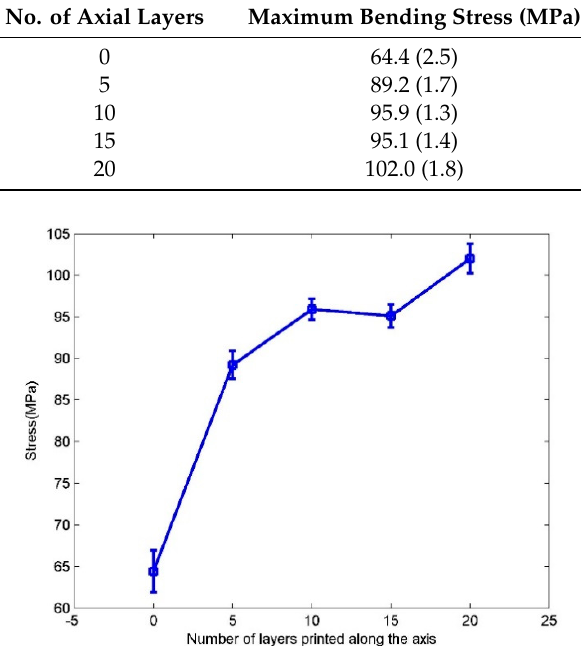
Figure 25. Three-point bending test of the maximum stress of each group.